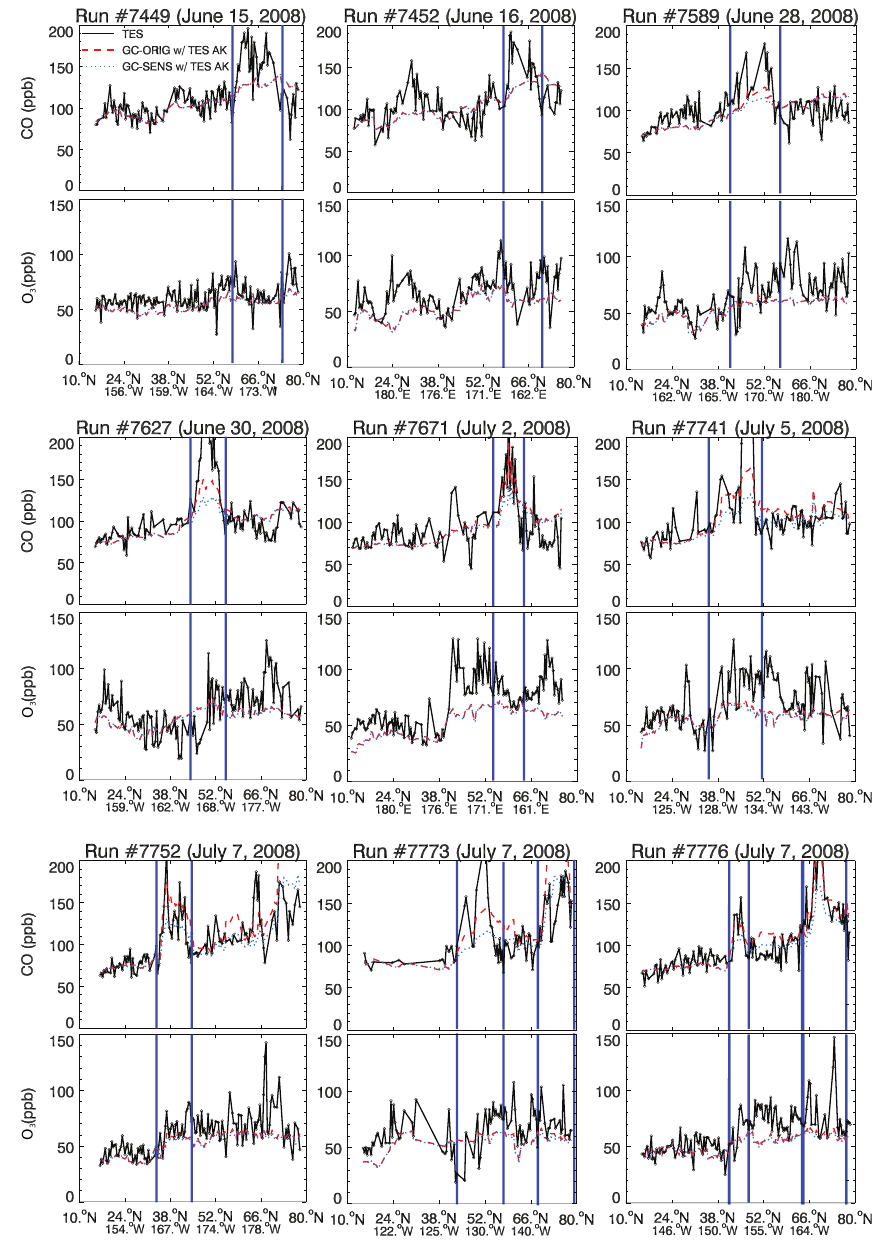
Fig. 15. Same as Figure 12 but for nine TES runs influenced by biomass burning smoke from